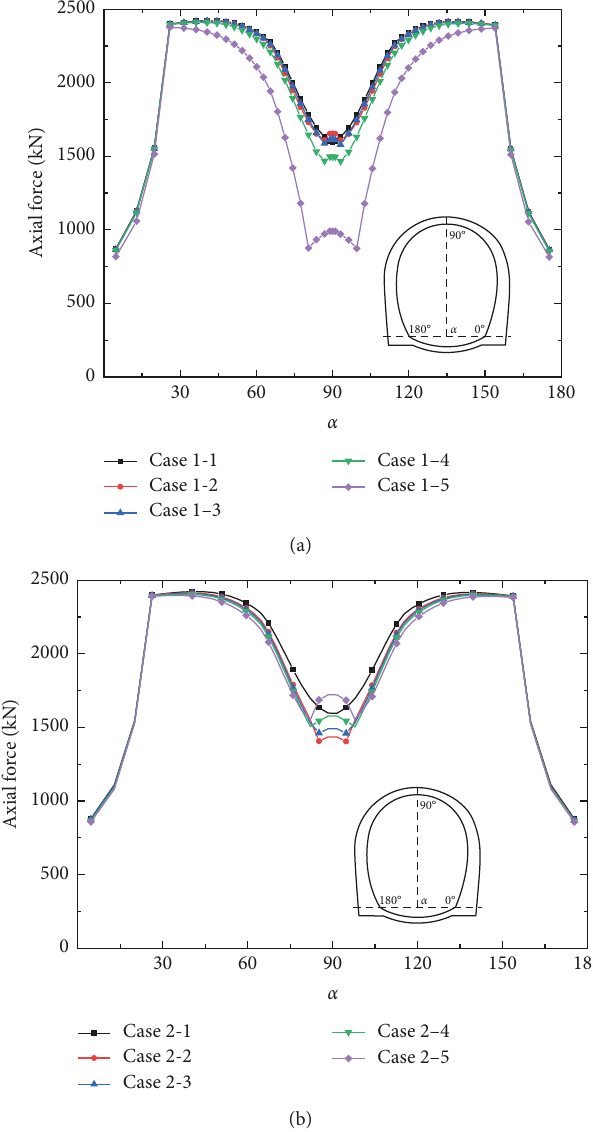
Figure 4: Axial forces of concrete lining. (a) Group 1. (b) Group